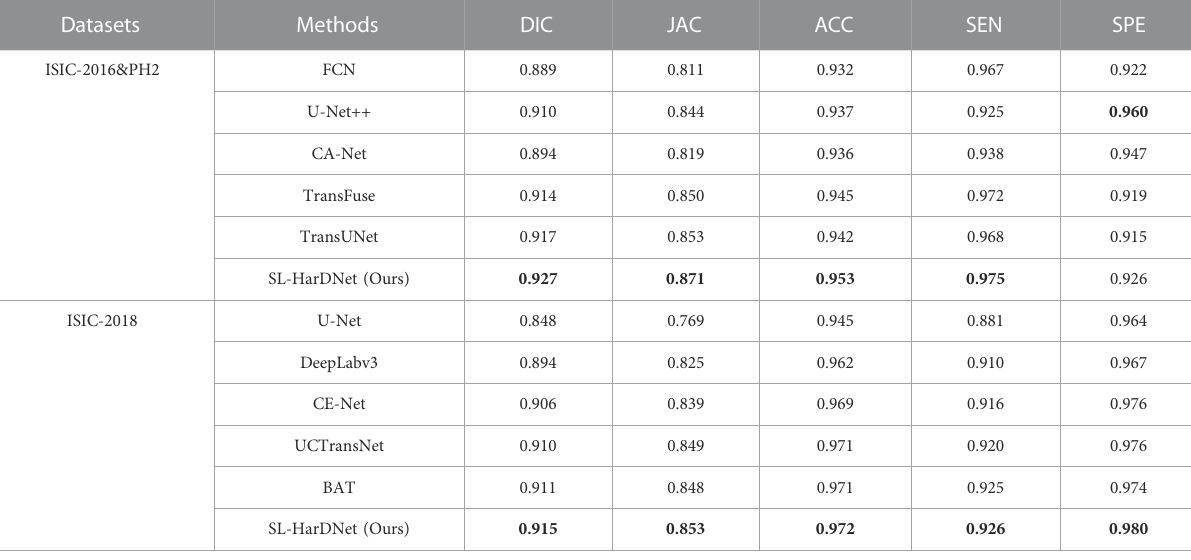
TABLE 2 Skin lesion segmentation performance of our SL-HarDNet and several popular segmentation methods on the ISIC-2016&PH2 test set and ISIC2018 dataset.